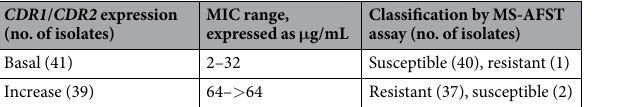
Table 2. MS-AFST assay results for the 80 C. glabrata isolates tested against fluconazole. Classification of the isolates as susceptible or resistant to the antifungal drug is shown according to the CDR expression levels and MIC